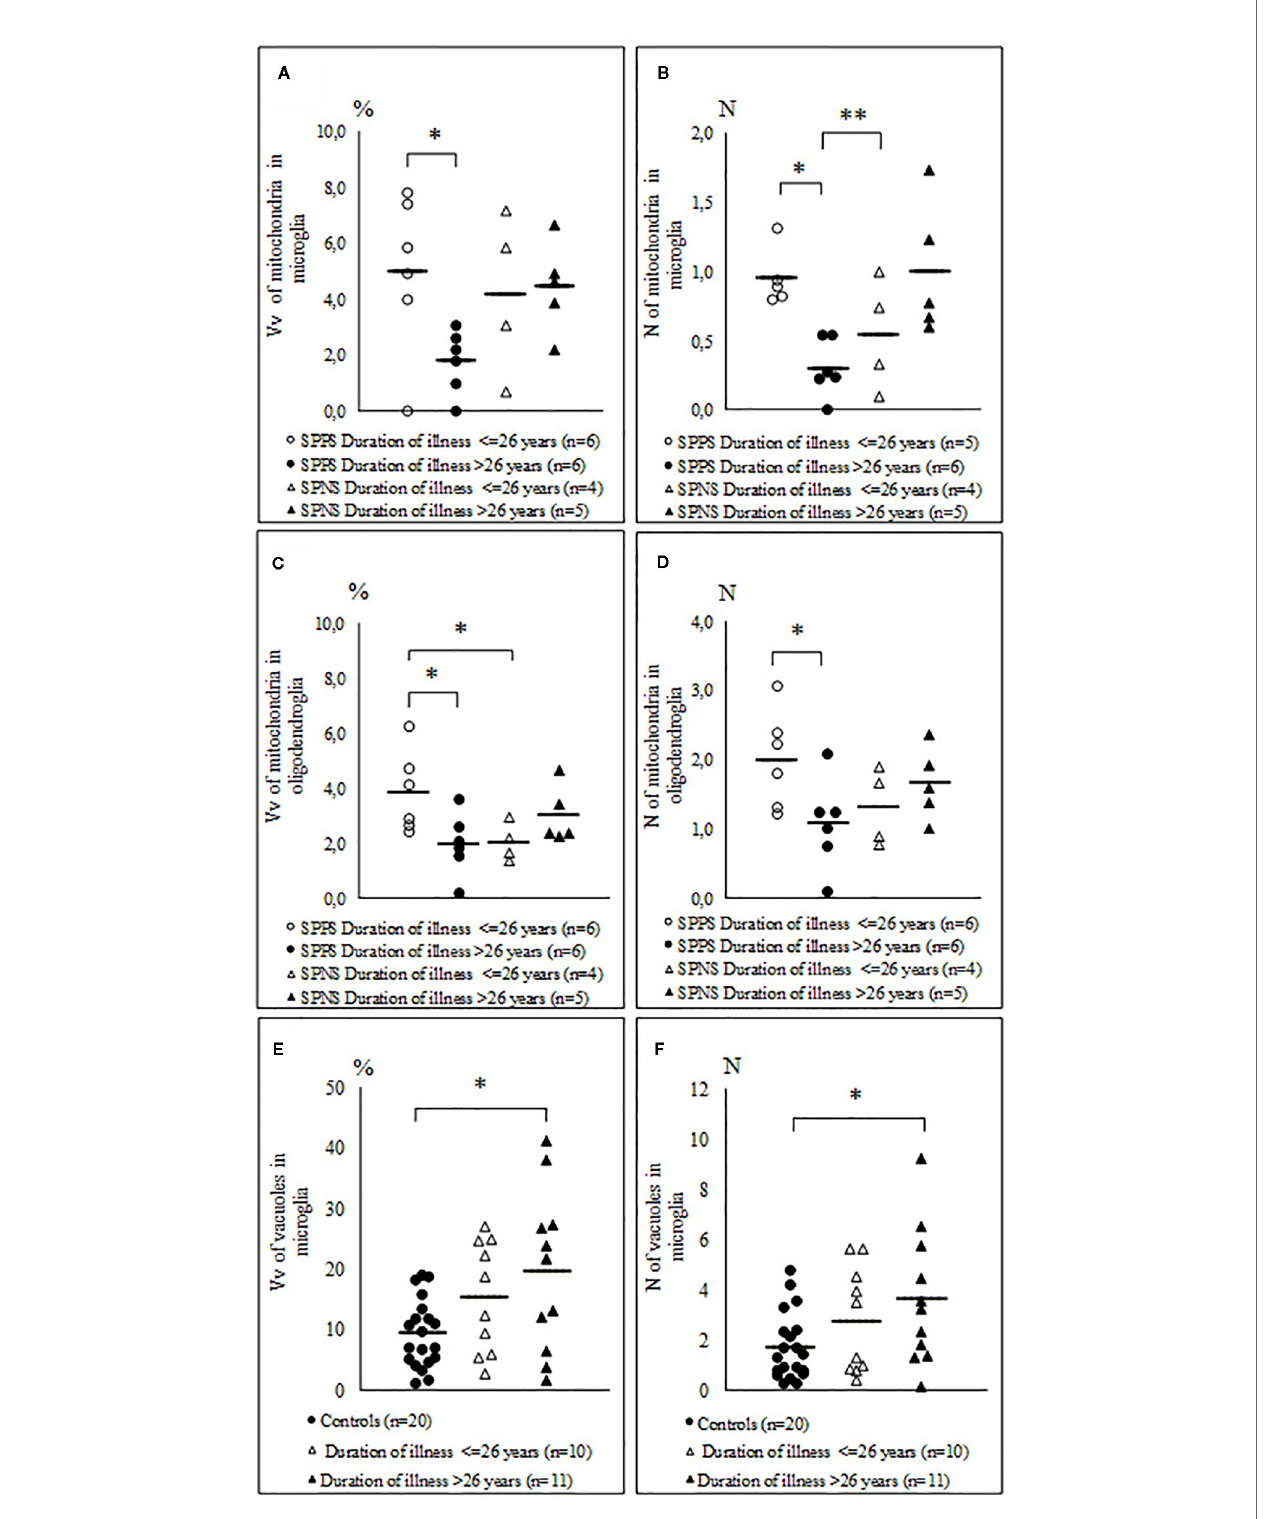
FIGURE 6 | Individual and mean values for Vv and N of mitochondria in microglia (A, B) , in oligodendrocytes (C, D) in the SPPS and SPNS subgroups with shorter (< 26 years) and longer (> 26 years) duration of disease and Vv and N of vacuoles in microglia in the subgroups with shorter (< 26 years) and longer (> 26 years) duration of disease as compared to the control group (E, F) . *p < 0.05; **p <